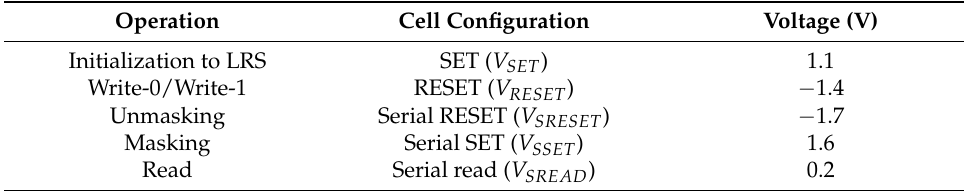
Table 1. Amplitudes of the voltage pulses used in the